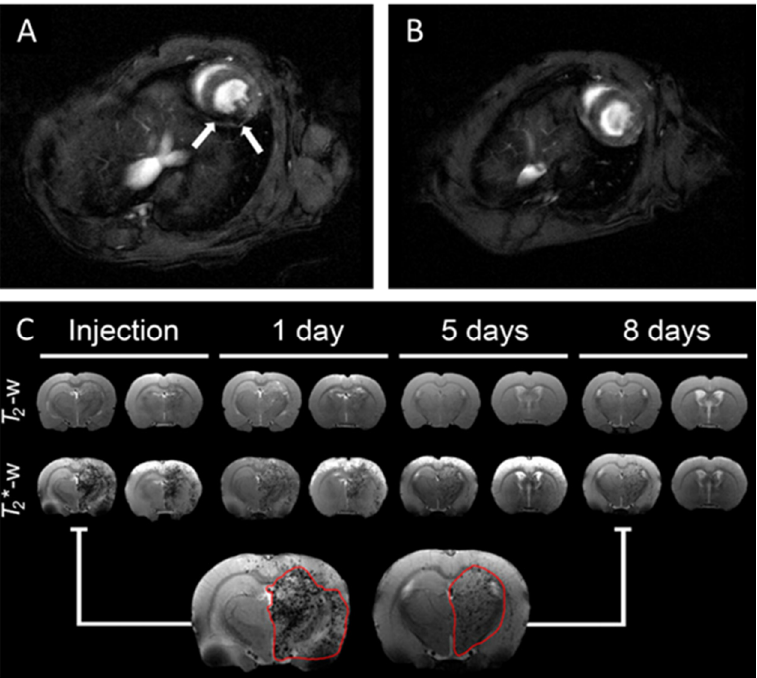
Figure 4. T 2 -weighted MR image of mouse ( A ) without and ( B ) with intracardially implanted SPION-labeled myoblasts. ( C ) T 2 /T 2 *-weighted cerebral MR images of mice intra-arterially injected with USPIO-PAA-GlcN-labeled mesenchymal stem cells after 1 h, 24 h, 5 days, and 8 days. ( A , B ) Reproduced with permission from Wierzbinski, K. R. et al., Scientific Reports; published by Nature Research, 2018. ( C ) Reproduced with from Guldris, N. et al., Bioconjugate Chemistry; published by American Chemical Society, 2017.